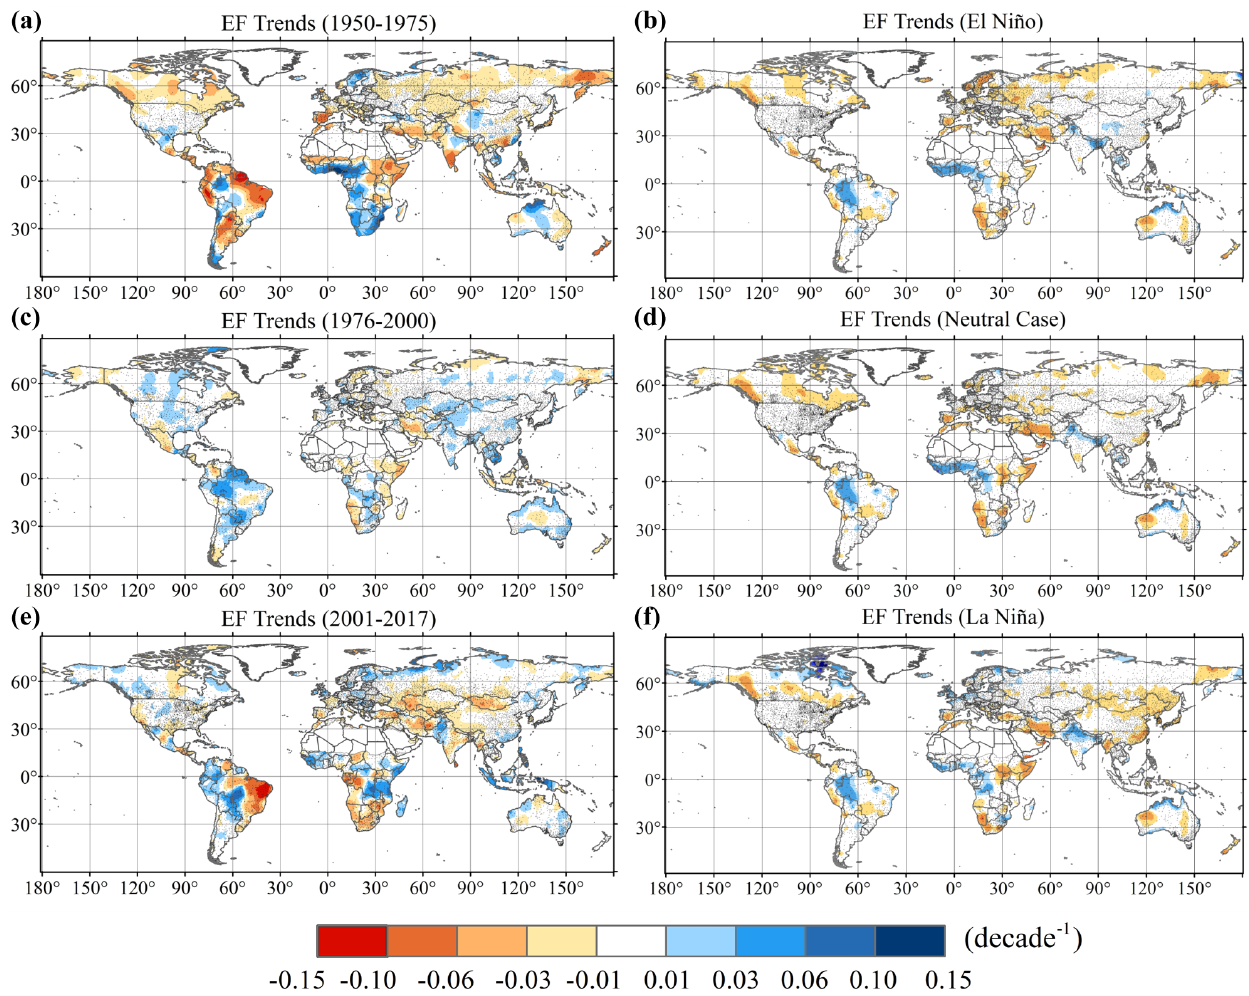
Figure 5. Spatial patterns of EF trends during different periods. (a–c) The spatial patterns show EF trends during different historical periods. (d–f) The spatial patterns show EF trends during the El Niño period, a neutral case period and the La Niña period, respectively.